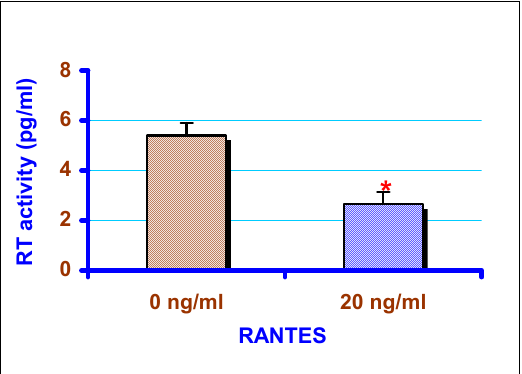
Figure 5. Exogenous rHu RANTES decreases RT activity of CAEV in vitro . CAEV replication was assessed by measuring RT activity present in the GSM cell- culture supernatants. Supernatants were collected 72h post-infection for RT analysis. Mean RT value of RANTES was 2.65 ng/ml compared to 5.4 ng/ml of control (no chemokine added) sample. *indicates significant difference from control (P ≤